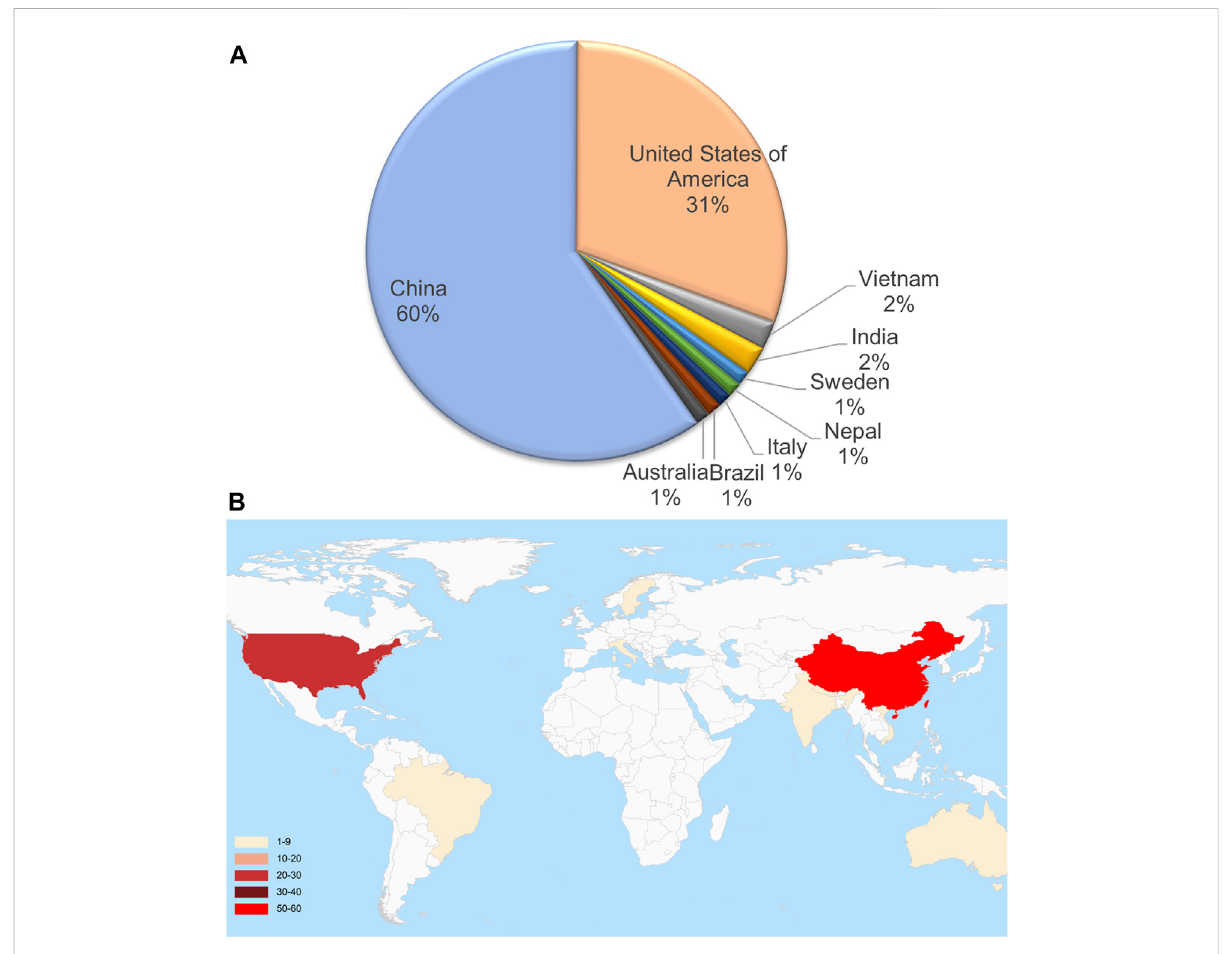
The proportion (A) and geographic locations (B) of 92 full-length sequenced SARS-CoV-2 genome